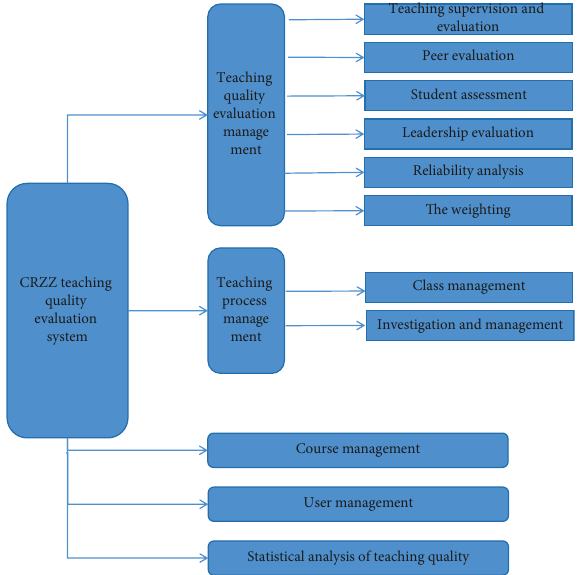
Figure 9: Overall structure of CRZZ teaching quality evaluation